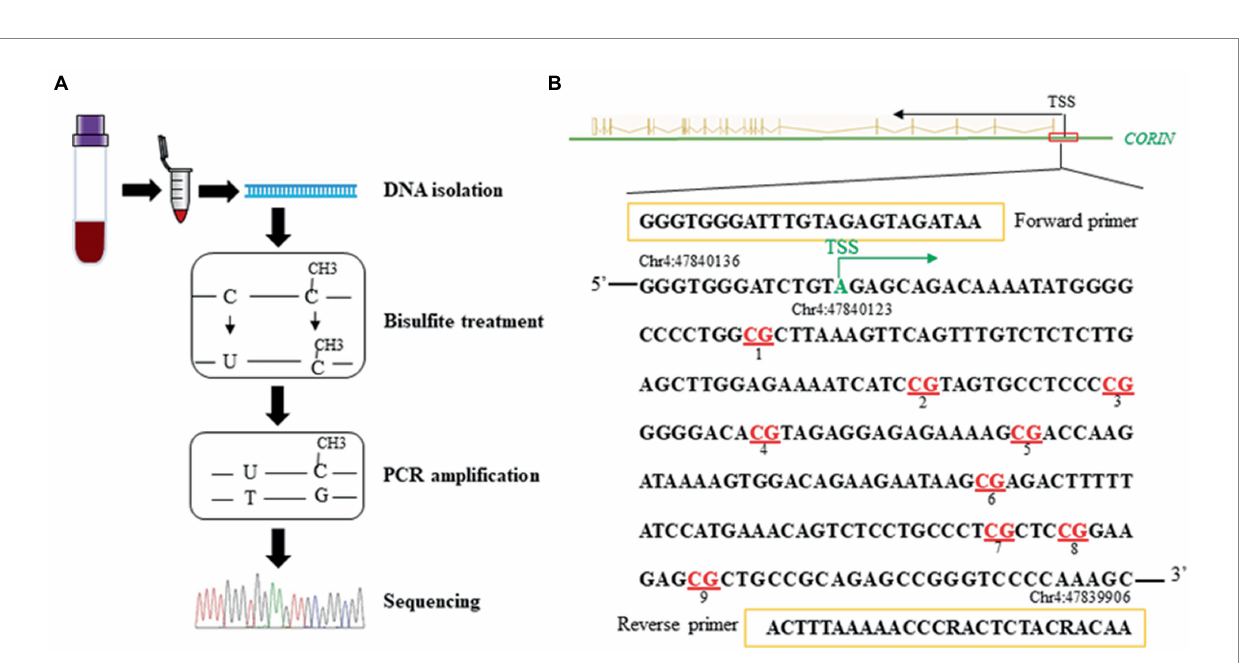
FIGURE 2 A schematic illustration of the methods (A) and the targeted sequence and primers (B) for targeted bisulfite sequencing. Red represents the CpG loci assayed in the CORIN gene promoter (+27 ~ +190 bp from TSS). TSS: transcriptional start